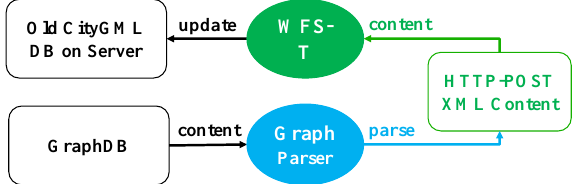
Figure 10. Retrieving XML contents of a CityGML object using a Graph-to-CityGML